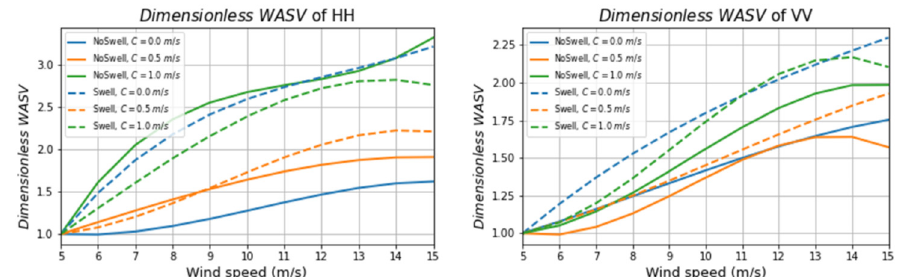
Figure 11. The relationship between dimensionless WASV and wind speed for HH and VV polarizations. The swell direction, amplitude, and wavelength were 0 ◦ , 0.5 m, and 200 m, respectively. Other input parameters were set to the values indicated in Table 1. The presence and absence of swell are indicated by line style: solid line indicates no swell, dashed line indicates the presence of swell. The magnitude of the current velocity is indicated by color.